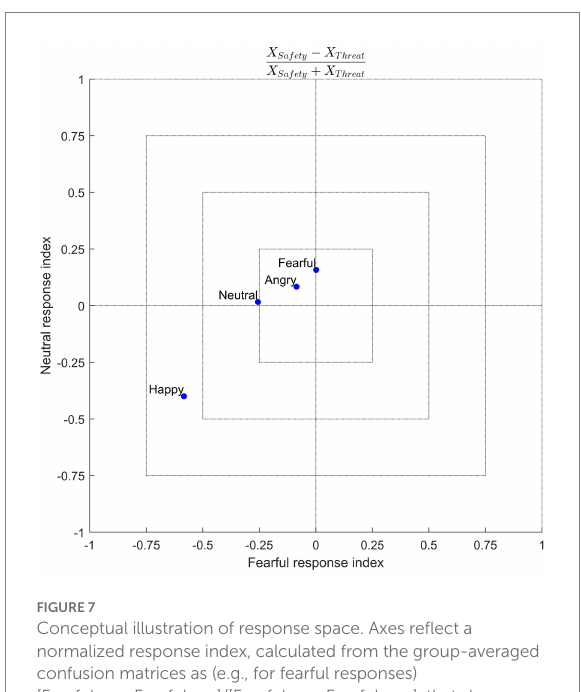
FIGURE 7 Conceptual illustration of response space. Axes reflect a normalized response index, calculated from the group-averaged confusion matrices as (e.g., for fearful responses) [Fearful Safety − Fearful Threat ]/[Fearful Safety + Fearful Threat ], that shows a response bias in the safety (positive values) or threat (negative values) contexts for each of the four emotion conditions (blue dots). Here one sees that fearful and neutral responses were more common on trials in which a happy face was presented in the threat context. This conceptualization demonstrates the extent to which the threat context selectively biases the response space for non-negative